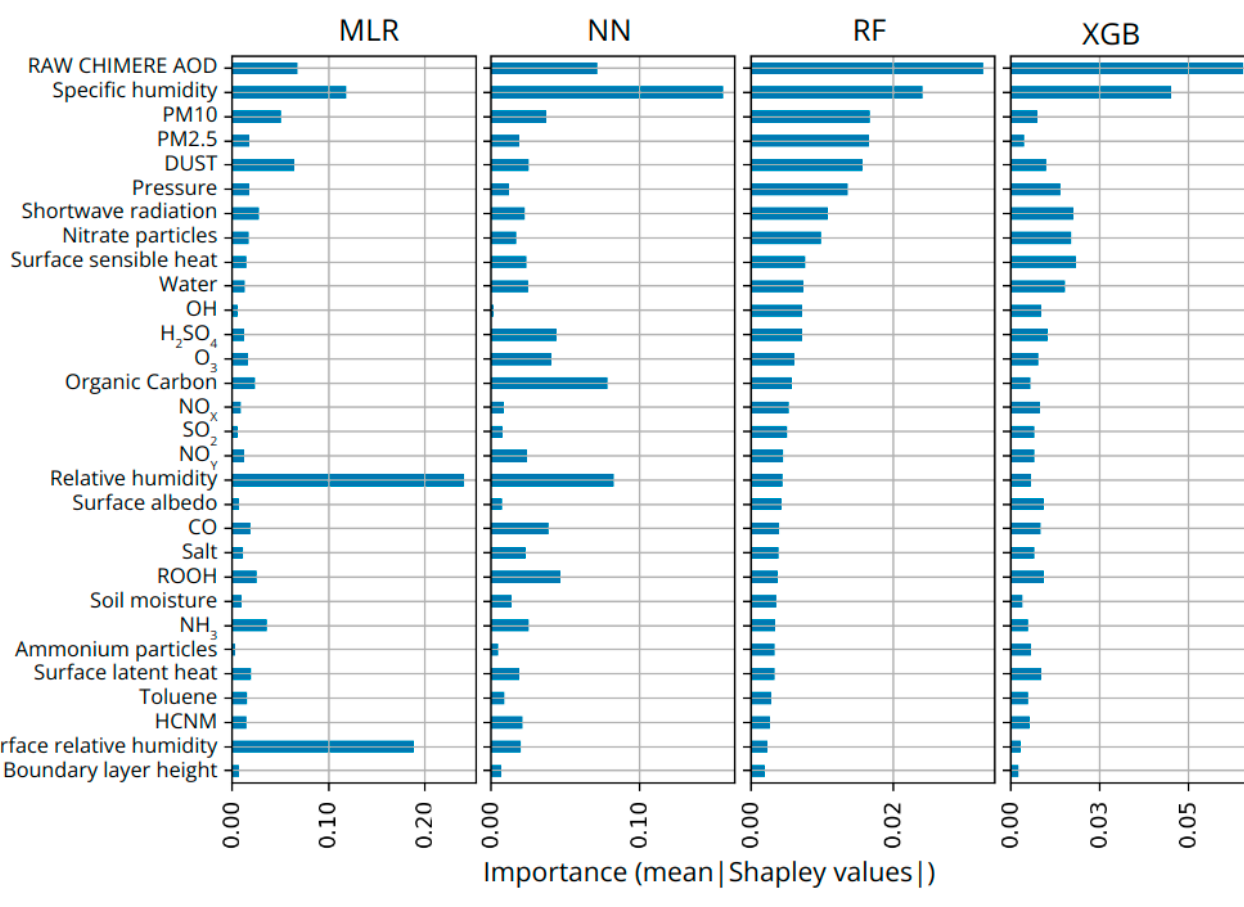
Figure 7. Shapley values for ( a ) hydroperoxide (ROOH) and ( b ) non-methane hydrocarbons (NMHC) for MLR model for the 30 September 2021. b.